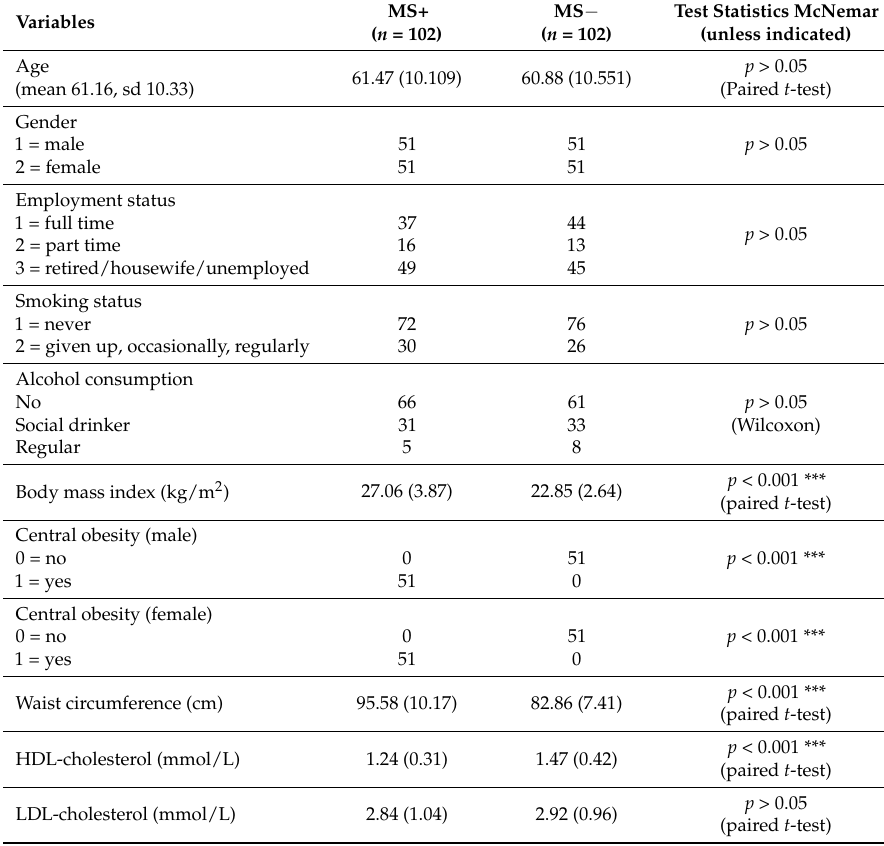
Table 1. The sociodemographic, family, and medical conditions of the